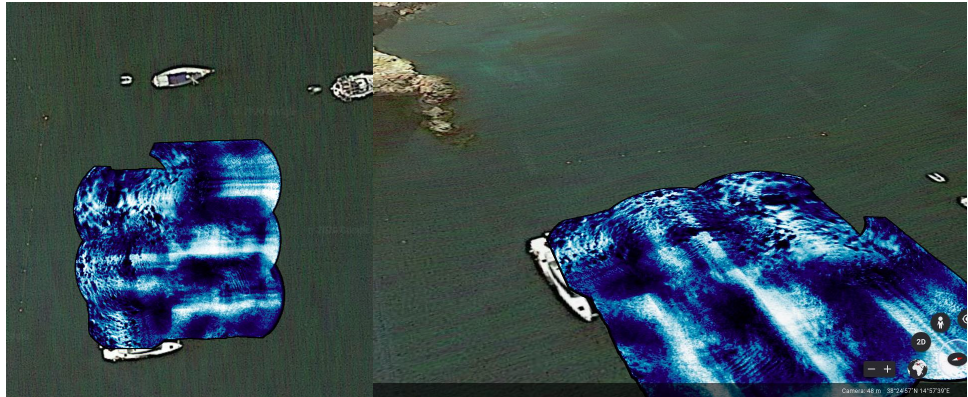
Figure 5. Google Earth image of the test site overlaid with the underwater acoustic